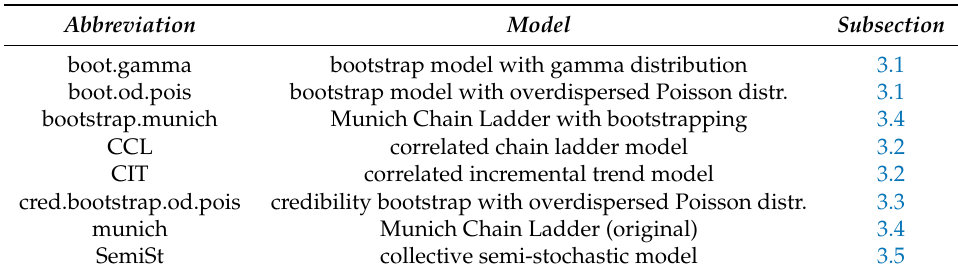
Table 9. Legends of reserving